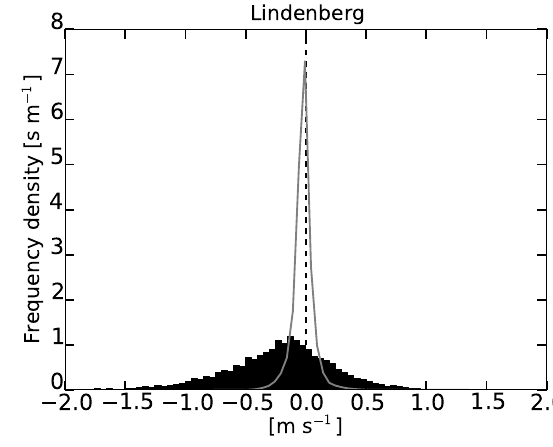
Fig. 4. Same as Fig. 3, but for